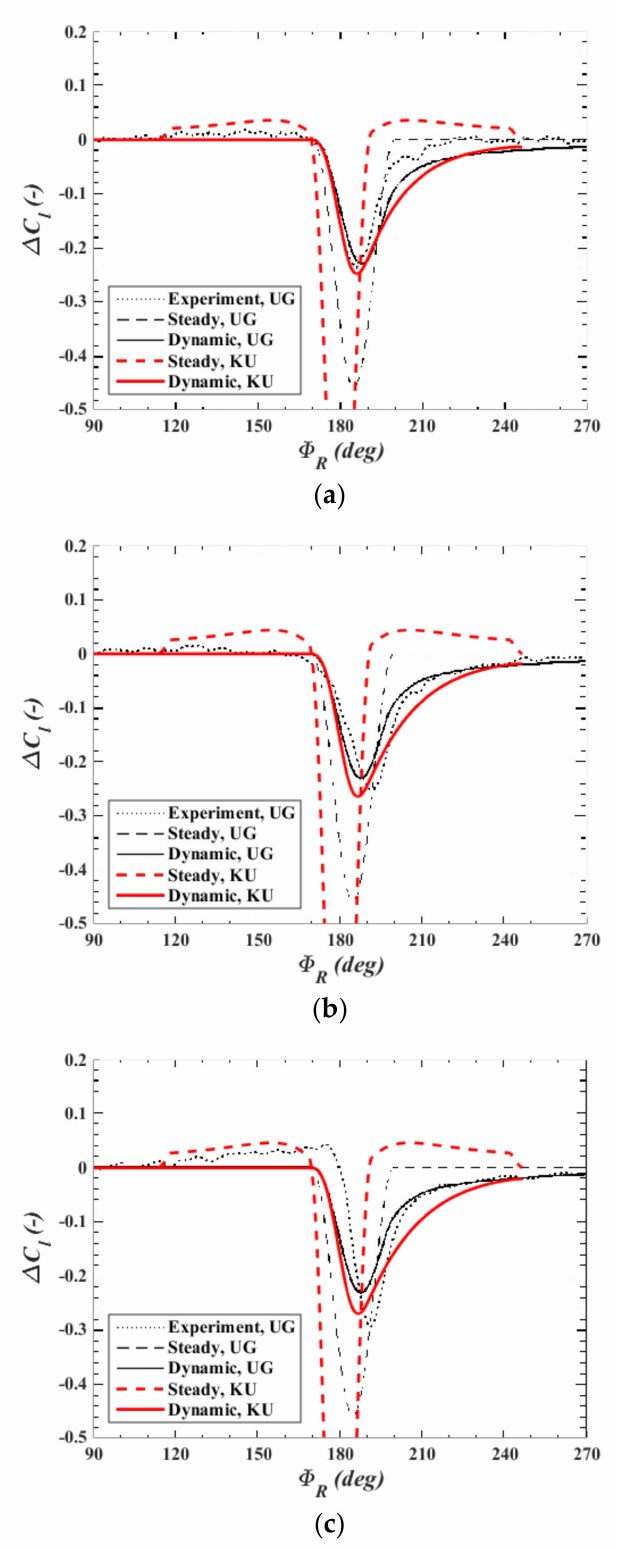
Figure 6. Deviations in the lift coe ffi cient at η B = 75% according to the present method with Munduate’s threshold, C d = 1.2 [24]: ( a ) Case 1: V T = 36.0 m / s; ( b ) Case 2: V T = 44.1 m / s; ( c ) Case 3: V T = 46.7 m /